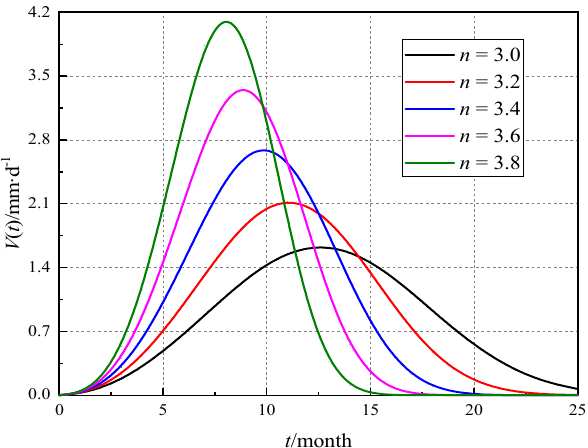
Figure 2. The influence of model order n on surface subsidence.